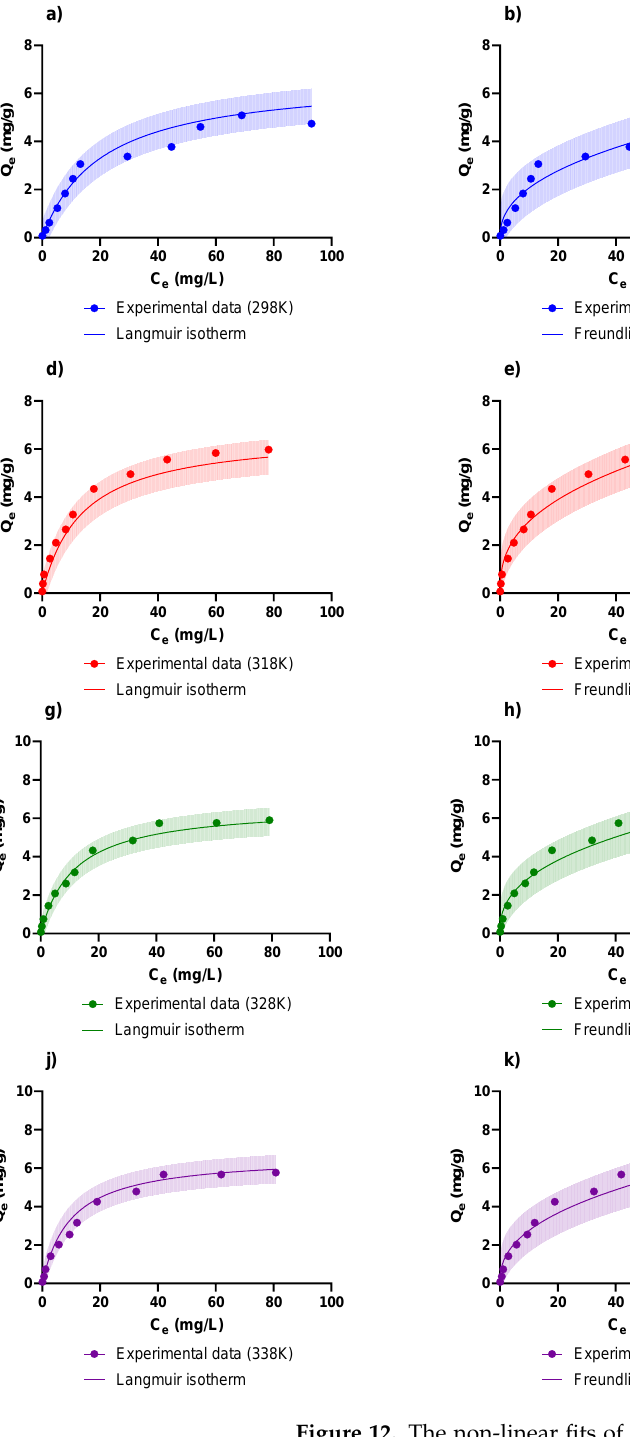
Figure 12. The non-linear fits of the isotherm models from: ( a ) Langmuir (298K), ( b ) Freundlich (298K), ( c ) Two Surface Langmuir (298K), ( d ) Langmuir (318K), ( e ) Freundlich (318K), ( f ) Two-surface Langmuir (318K), ( g ) Langmuir (328K), ( h ) Freundlich (328K), ( i ) Two-surface Langmuir (328K), ( j ) Langmuir (338K), ( k ) Freundlich (338K) and ( l ) Two-surface Langmuir (338K). The shaded areas indicate the 95% prediction intervals.